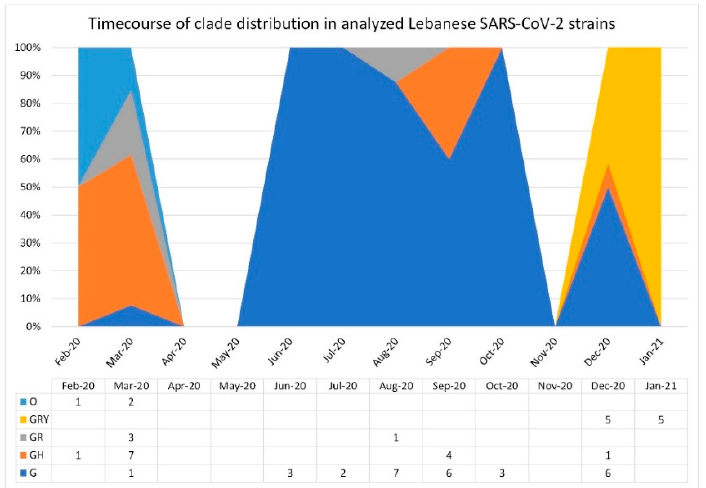
Figure 2. Time course GISAID clade distribution of the analyzed Lebanese SARS-CoV-2 strains over the last year. A data table with legend keys is shown directly under the chart.